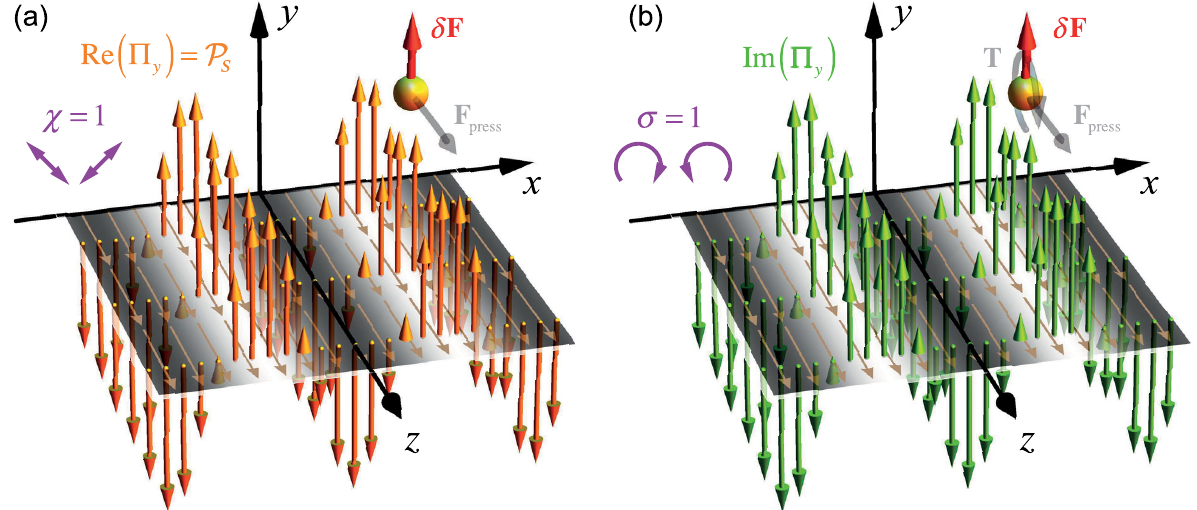
FIG. 3. Transverse polarization-dependent momenta in the two-wave interference field. (a) Distribution of Belinfante ’ s spin momentum x Þ [ “ virtual ” part of the real Poynting vector Re ð Π Þ ] in the case of diagonally polarized waves with m 1 ¼ − m 2 ¼ 1 , density [Eq. (12)] P S ð i.e., the Stokes parameters ð τ ; χ ; σ Þ ¼ ð 0 ; 1 ; 0 Þ (cf. the Fedorov-Imbert transverse momentum in evanescent waves [10]). (b) Distribution of x Þ(cid:3) [Eq. (13)] for circularly polarized waves with m 1 ¼ − m 2 ¼ i , the y component of the imaginary Poynting momentum density Im ½ Π y ð i.e., the Stokes parameters ð τ ; χ ; σ Þ ¼ ð 0 ; 0 ; 1 Þ . Despite the planar two-wave interference, both of these noncanonical momenta have the transverse y -directed components, which are strongly polarization dependent. Namely, the distributions in (a) and (b) are flipped when the polarizations are changed to the opposite: χ ¼ − 1 and σ ¼ − 1 . An absorbing probe particle is shown here at the x position corresponding to Φ ¼ π , and the optical forces and torques are indicated schematically. The spin and imaginary Poynting momenta do not exert radiation pressure in the dipole-coupling approximation, but do cause a weak polarization-dependent optical force [Eq. (16)] (shown in red), δ F ∝ Re ð Π P ∝ Im ð Π and δ F in the higher-order approximation (see Fig. 4 for numerical simulations). The particle y y Þ ¼ Sy y y Þ